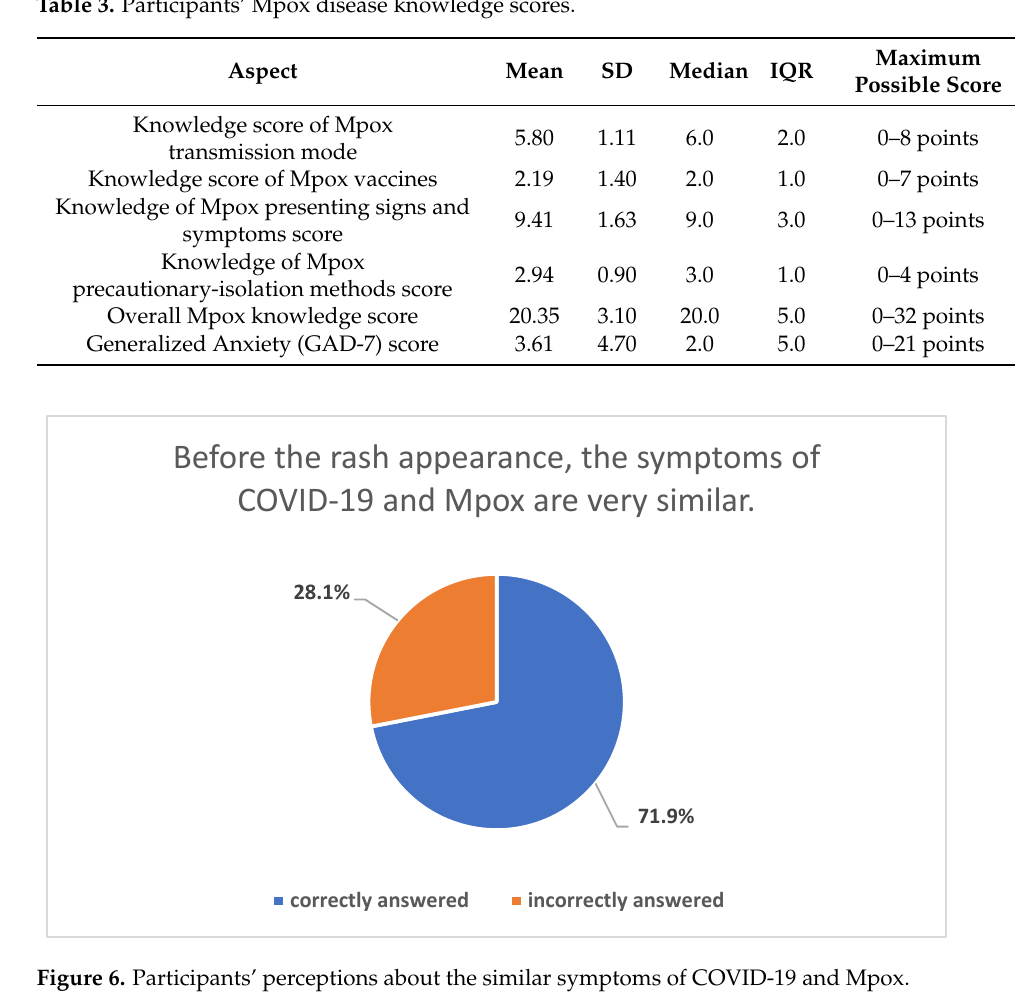
Table 3. Participants’ Mpox disease knowledge scores.